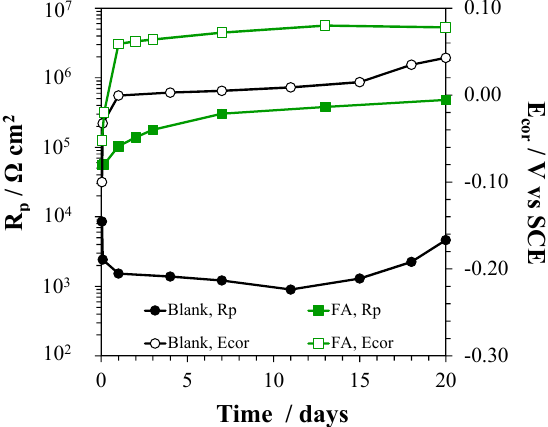
Figure 13. Time dependence of R p (solid symbols) and E cor (empty symbols) of bronze in AR × 10 both in the absence (dots) and in the presence (squares) of suspended FA particles.